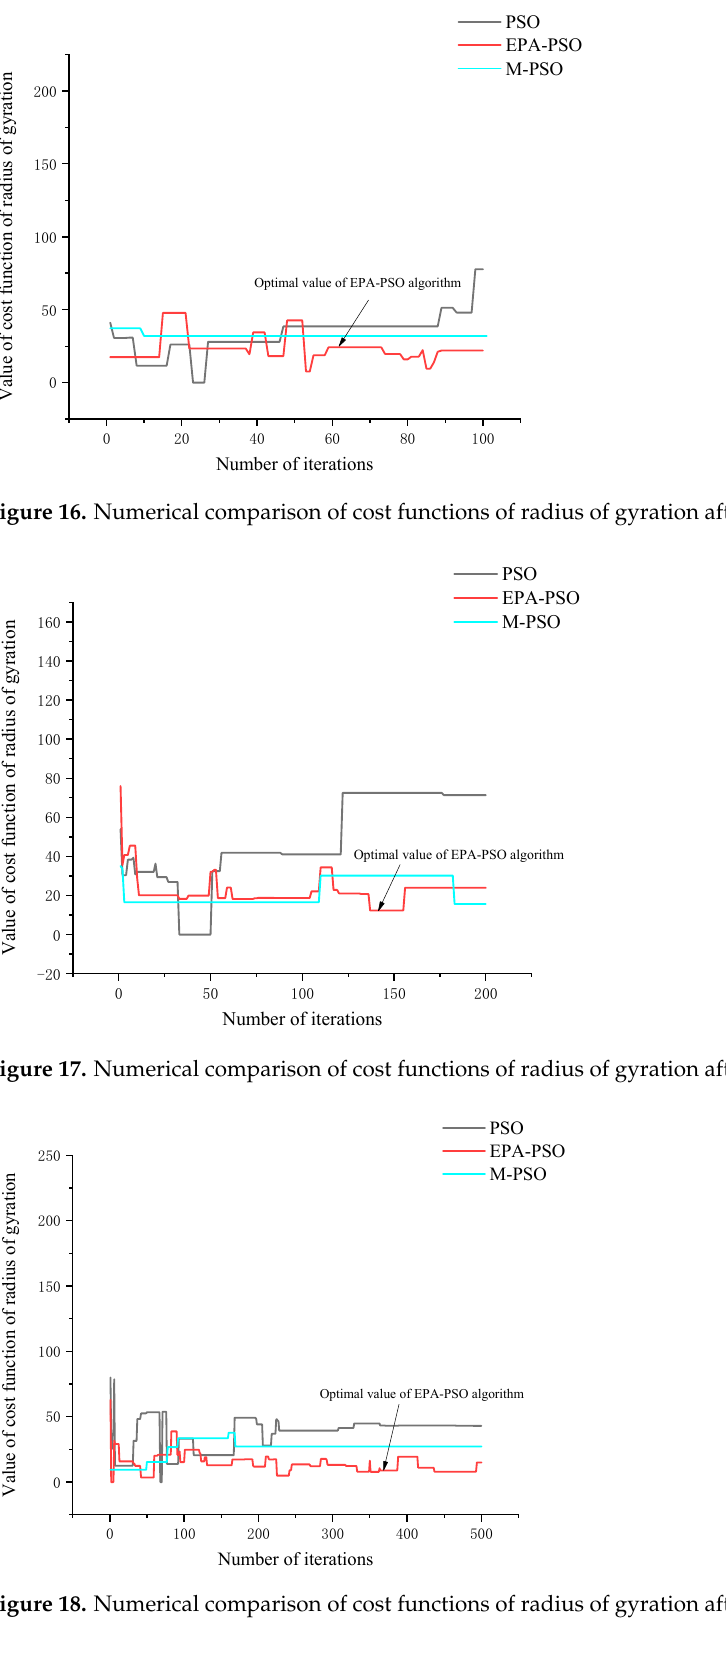
Figure 19. Numerical comparison of cost functions of trim angle after 100 iterations. 0